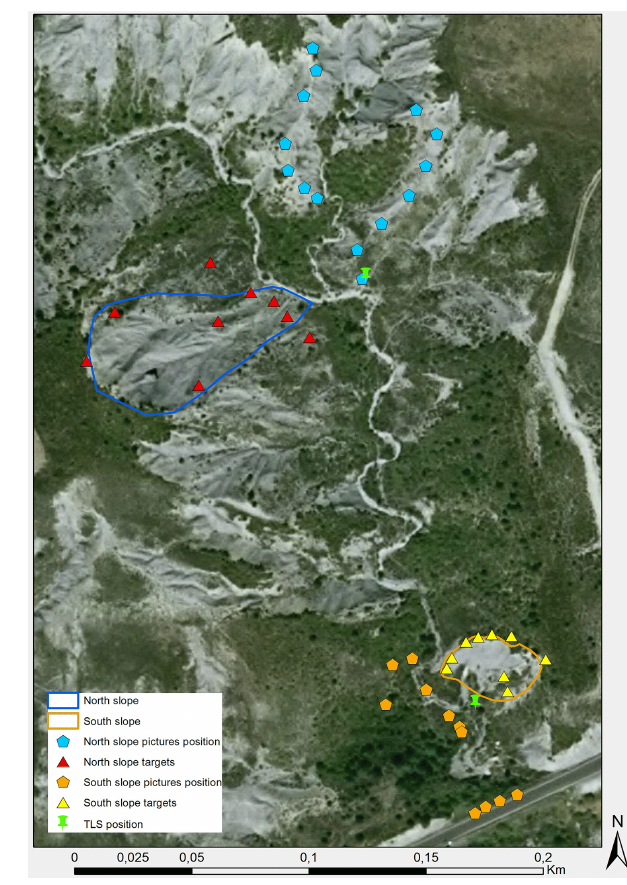
Figure 3. Field site location, Araguás catchment. Detailed image of both selected